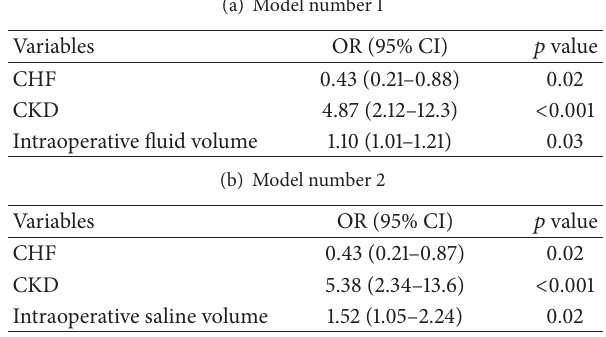
Table 4: Multivariate stepwise logistic regression models for predic- tors of postoperative